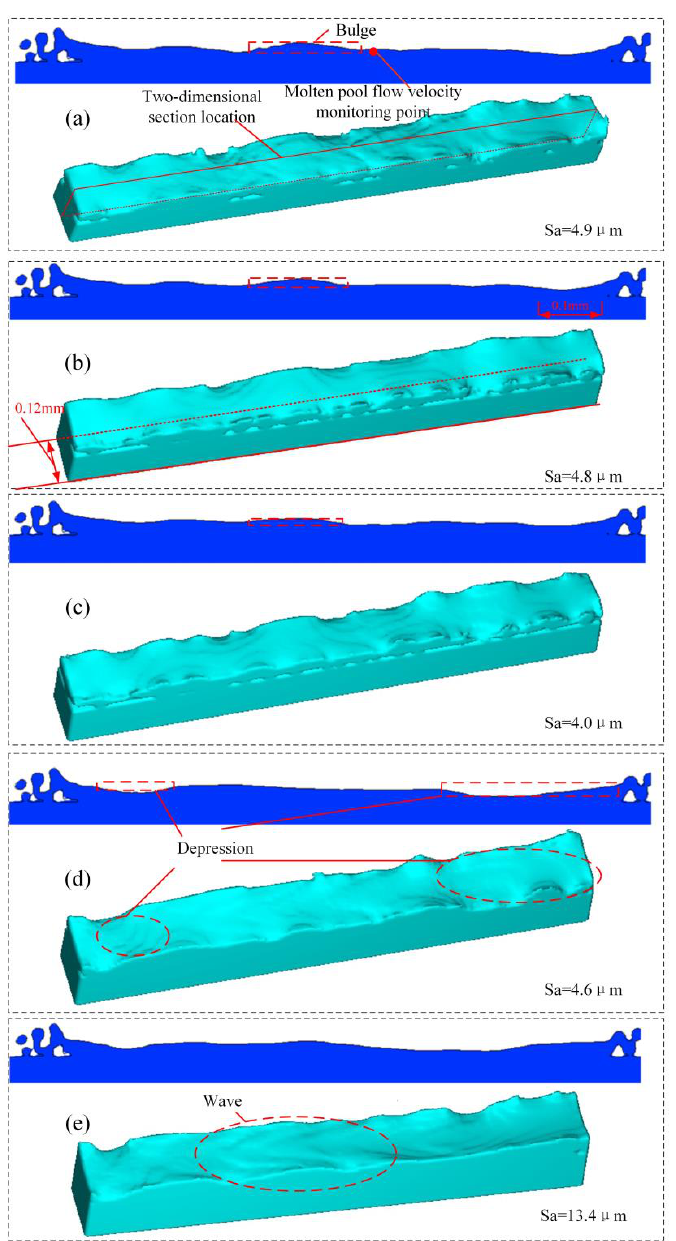
Figure 12. Surface morphology. ( a ) As received; ( b ) 50 W; ( c ) 90 W; ( d ) 130 W; ( e ) 170 W. The parameters of SLM were 150 W, 0.8 m/s and 0.05 mm. The other parameters of ILP were 0.8 m/s and 0.05 mm. The length of the plane domain is 1 mm, and the height is 0.15 mm. The size of the 3D domain is 1 mm × 0.12 mm × 0.2 mm.